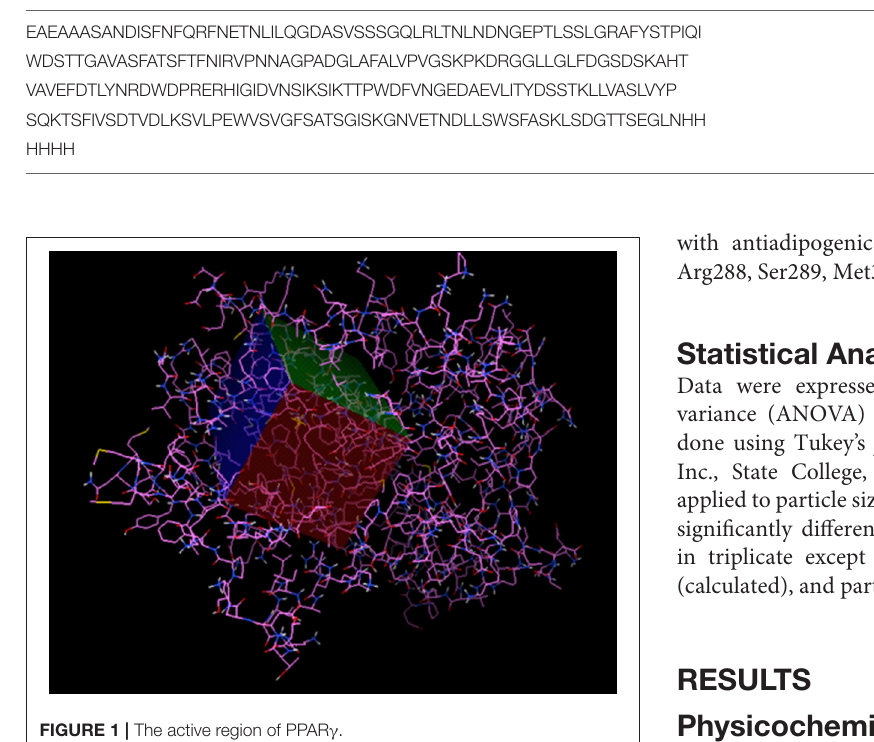
TABLE 1 | The amino acid sequence of the lectin protein in FASTA format from tepary bean ( Phaseolus acutifolius ).